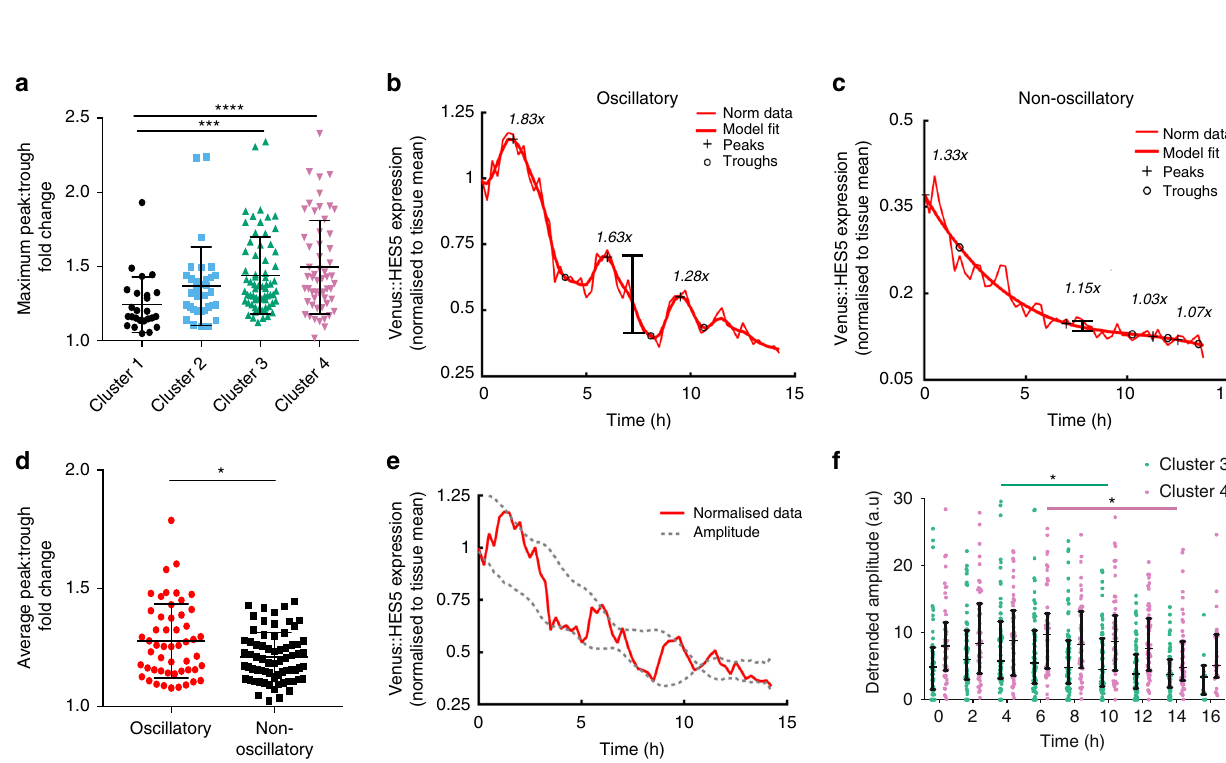
Fig. 7 HES5 oscillations on a downward trend increase fold-changes. a Maximum peak-to-trough fold-change in single cell Venus::HES5 expression per cluster. Kruskal – Wallis with Dunn ’ s multiple comparison test shows cluster 1 vs. 3 adjusted p = 0.0008 (***), cluster 1 vs. 4 adjusted p < 0.0001 (****). 181 cells, three experiments clustered separately. Cluster 1 ( n = 27 cells), cluster 2 ( n = 33 cells), cluster 3 ( n = 67 cells), cluster 4 ( n = 54 cells). Peak: Trough fold change is calculated from normalised Venus::HES5 expression including trend. Examples of single-cell Venus::HES5 timeseries in cluster 3 with ( b ) oscillatory and ( c ) non-oscillatory expression. Bold lines indicate model fi t over normalised Venus::HES5 intensity. Plus sign indicates peak and circle indicates trough in intensity values, fold-changes between peak-trough are indicated at relevant peak. d Mean peak-to-trough fold-change in oscillatory ( n = 52 cells, three experiments) or non-oscillatory ( n = 69, three experiments) single-cell Venus::HES5 expression in differentiating cells in clusters 3 and 4. p = 0.027 (*) in Mann – Whitney test after two outliers removed. e Example single-cell timeseries of mean normalised Venus::HES5 expression (red) from cluster 3 showing amplitude death (amplitude indicated by dashed line). f Instantaneous amplitudes from Hilbert transformation of de-trended single cell Venus::HES5 expression observed over time. 121 cells from clusters 3 and 4 in three experiments clustered separately. Student ’ s t -test were used to compare maximum amplitude data in: cluster 3 against subsequent timepoints showing signi fi cant decay after 10 h p = 0.0470 (*), 12 – 16 h p < 0.0001; cluster 4 showing signi fi cant decay after 14 h p = 0.0153 (*) and p = 0.0195 for 16 h. Error bars — SD. Source data are provided in a Source Data fi